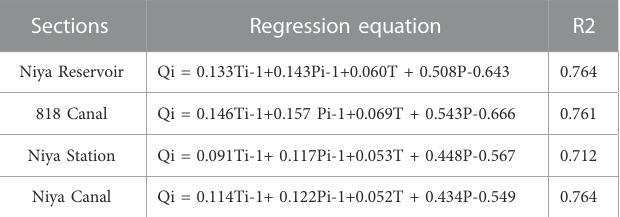
TABLE 2 Regression equation of the ecological base fl ow on the temperature and precipitation of the four sections. Sections